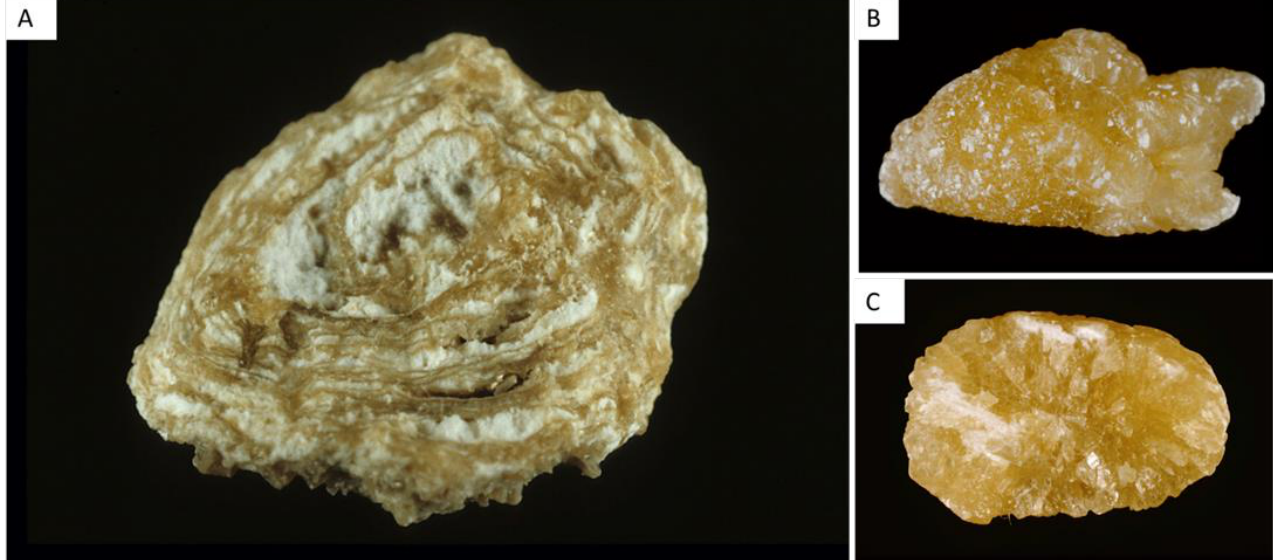
Figure 5. Other classic stones. ( A ) Type IIa + IVa stone with organization in successive concentric layers, characteristic of hypercalciuria associated with hyperphosphaturia. ( B , C ) cystine stone surface and section with a yellowish color, a rough surface with hexagonal crystallites and an inorganized